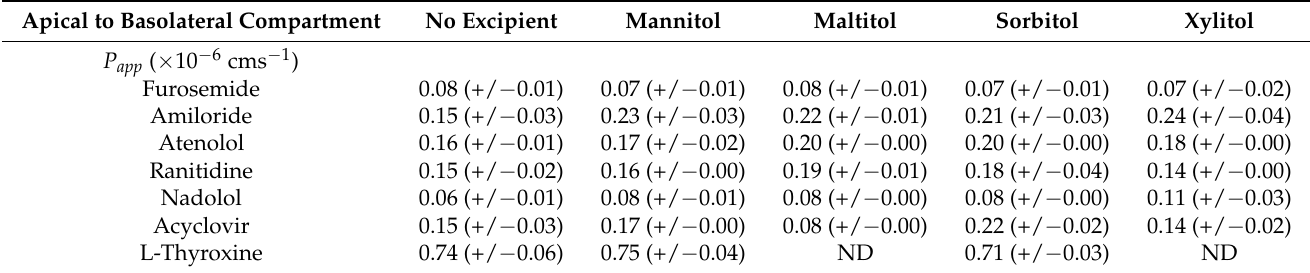
Table 5. Mean P app (+/ − standard deviation) of seven active substances in apical to basolateral Caco-2 permeability assay, either alone or in the presence of an excipient (ND: not